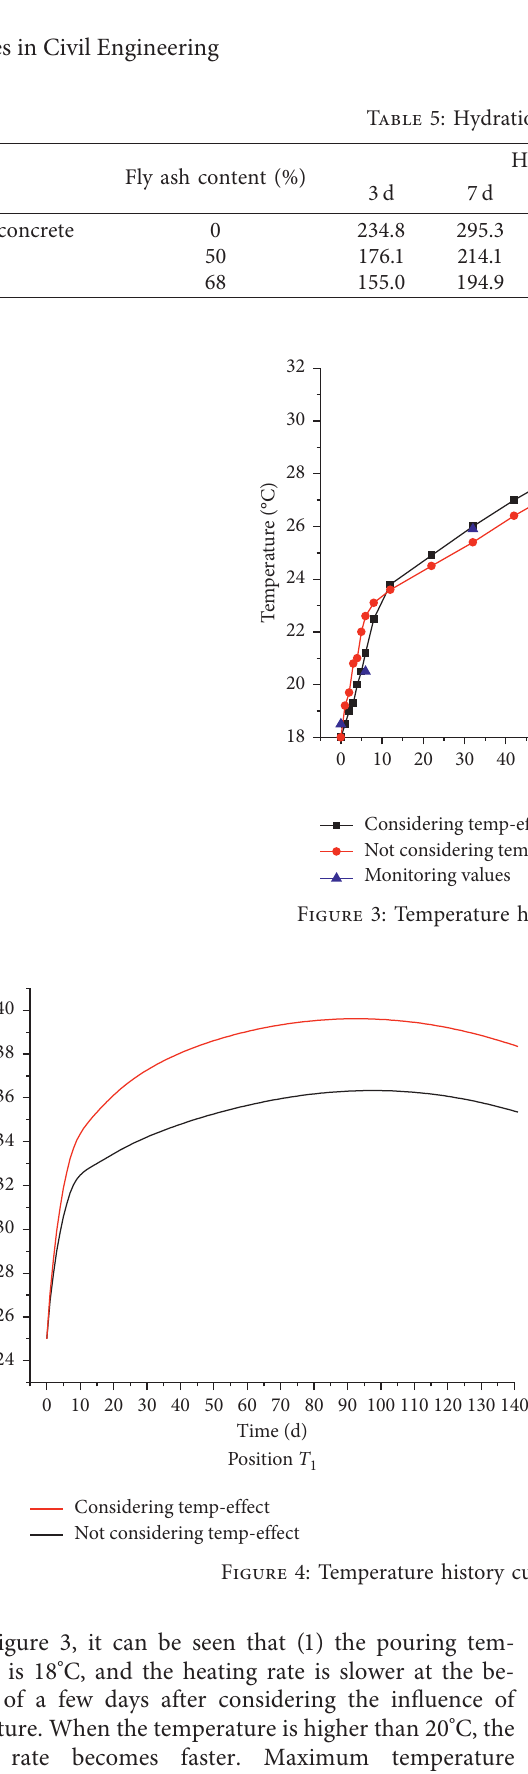
1 and position T 2